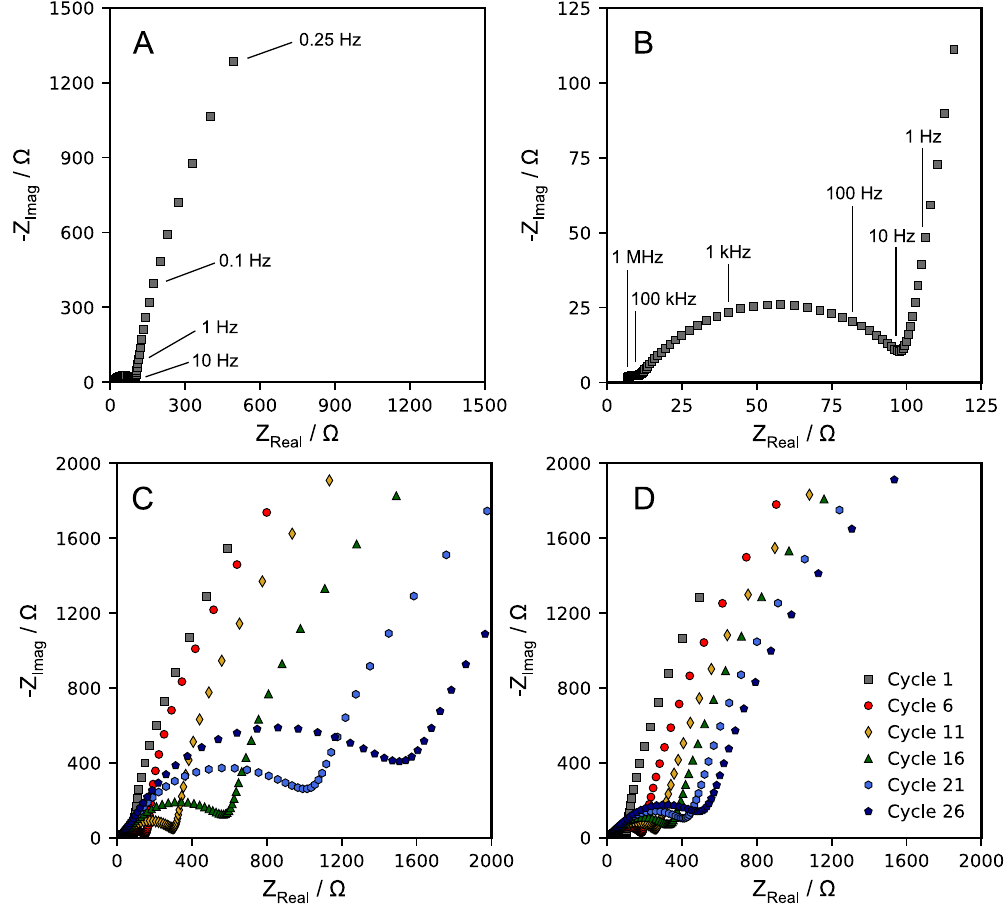
Figure 5. ( A ) EIS spectra of silicon electrode with 75 nm thick PMMA brush layer, acquired after first lithiation to 50 mV. ( B ) Higher frequency assignments of the impedance data shown in panel A. Three electrode PEIS measurements were taken during cycling of ( C ) bare silicon anodes and ( D ) silicon anodes coated with a 75 nm thick PMMA brush layer. The silicon anodes acted as the working electrode, lithium foil acted as counter and reference